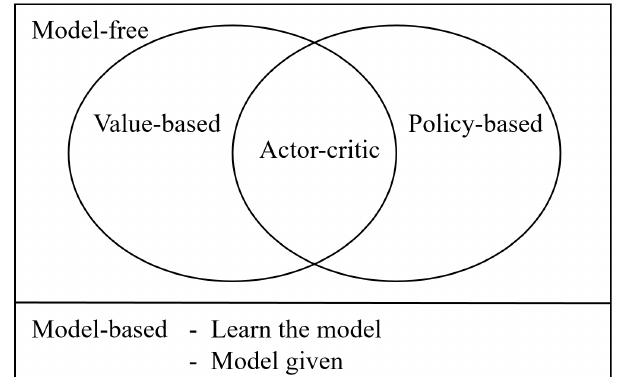
Figure 2. Reinforcement Learning Methods.